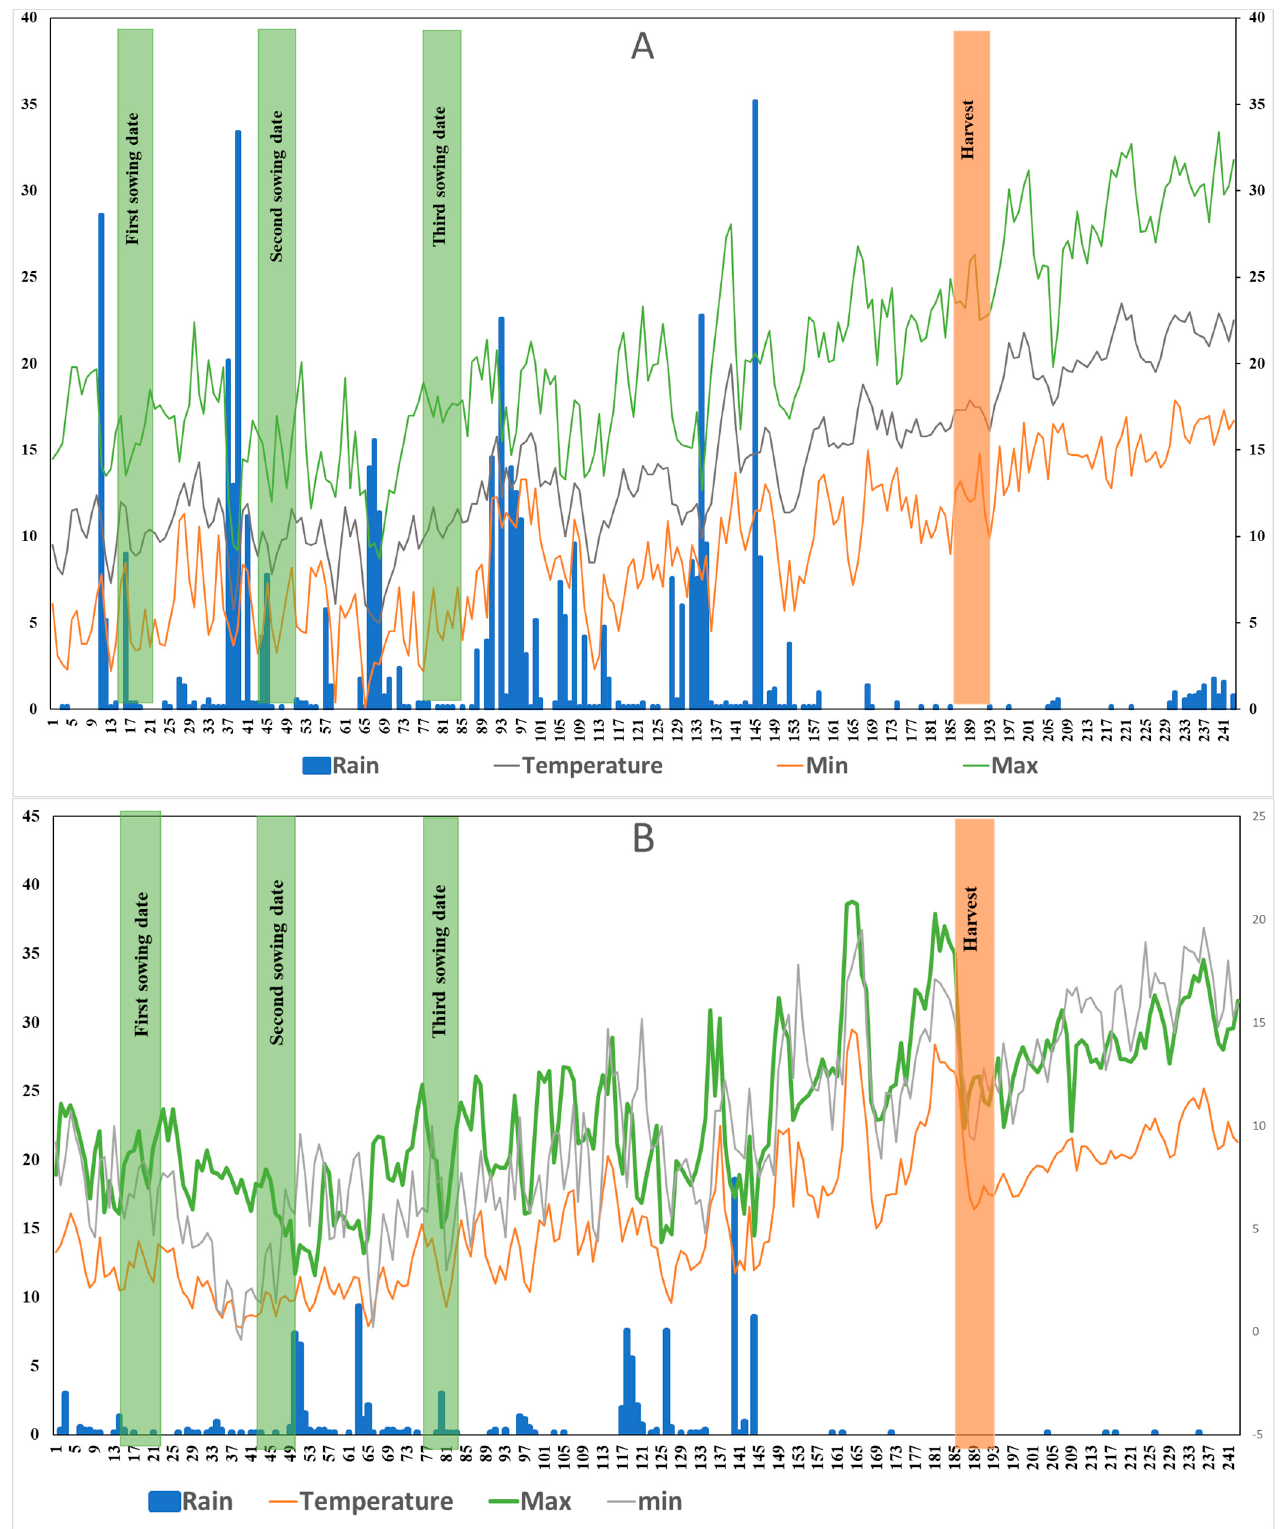
Figure 1. Daily maximum, minimum, average temperatures, and precipitation at the experimental site at Marchouch station during 2017/2018 ( A ) and 2018/2019 ( B ) cropping seasons. The treatments were released (Arifi: FLIP 98-50C; Farihan: FLIP 84-92C) and elite (FLIP-09-221C and FLIP 07-211) Kabuli chickpea genotypes (Table 1); three sowing dates (mid-December, mid-January, and mid-February). The three sowing dates represented